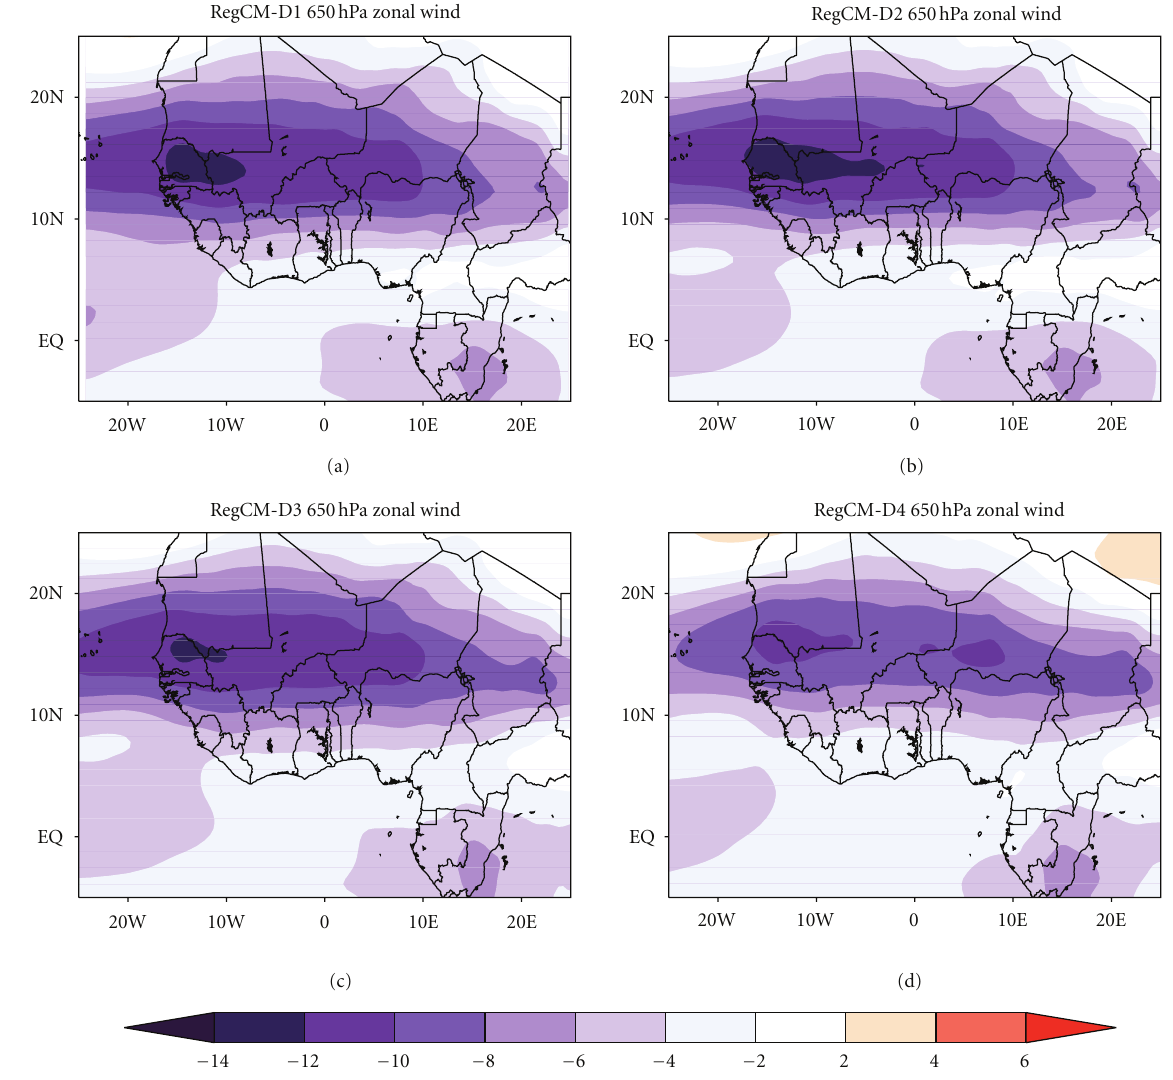
Figure 10: Mean JJA zonal wind at 650 hPa averaged for the period 2001–2005 for (a) RegCM-D1, (b) RegCM-D2, (c) RegCM-D3, and (d) RegCM-D4. Units are expressed in